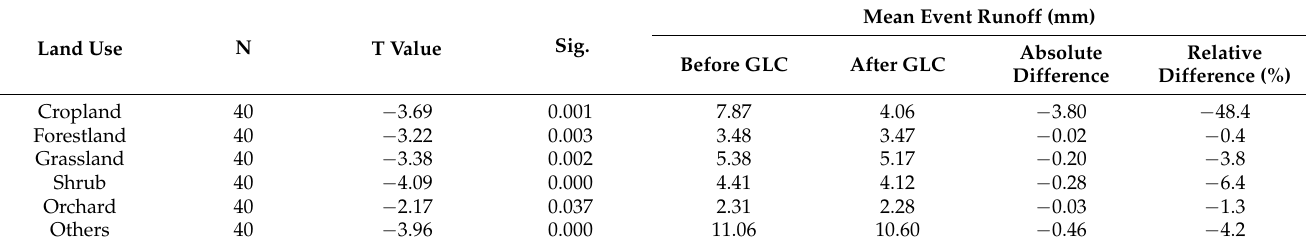
Table 7. Surface runoff in different land use